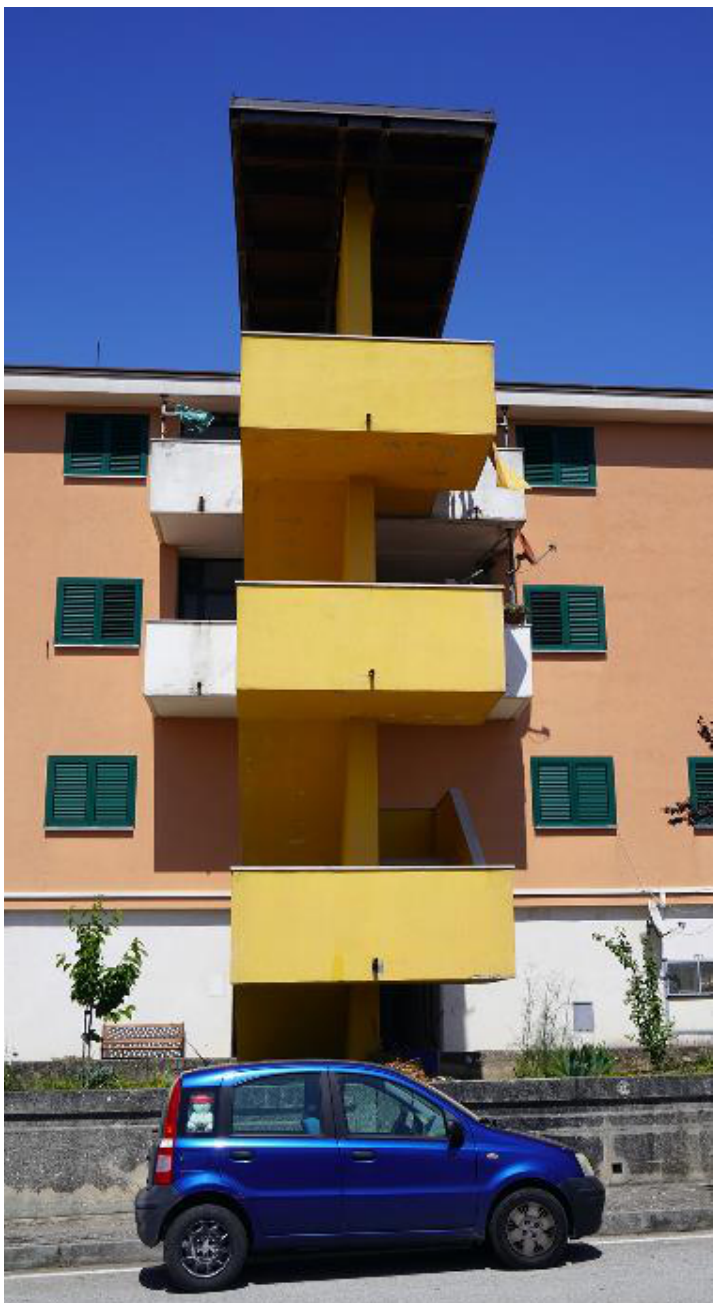
Figure 9. Castelnuovo di Conza: detail of new reinforced concrete buildings (photos by [35,36]).